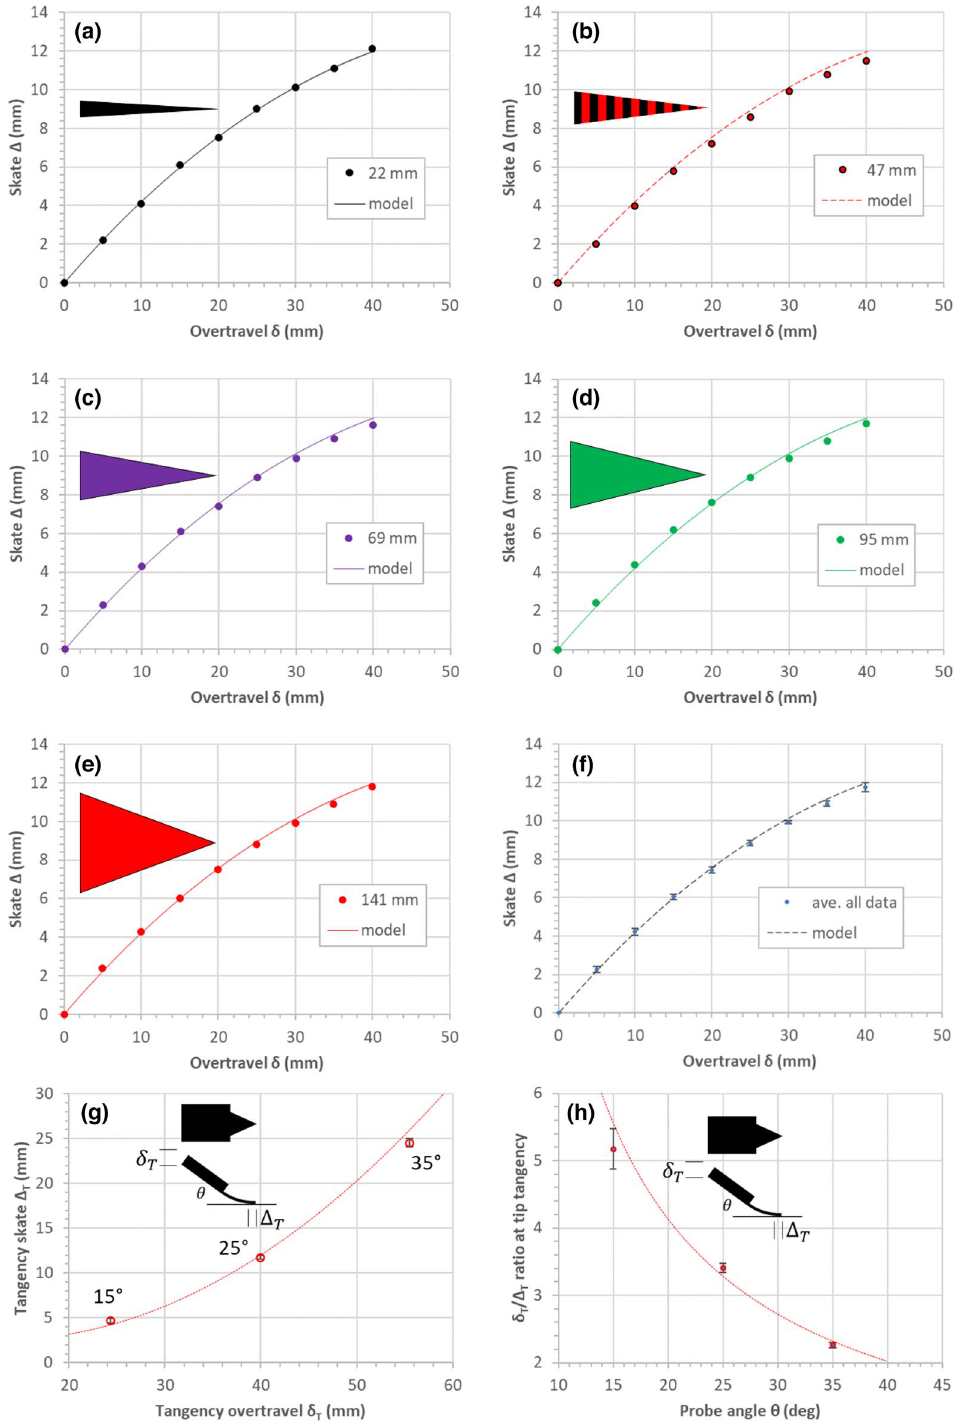
Figure 5. Experimental results of skate/overtravel of triangular cantilevers. ( a – e ) Skate versus overtravel for the five different triangulate cantilevers. ( f ) Averaged data plotted. ( g ) The tangency skate plotted as a function of tangency overtravel. ( h ) The tangency overtravel/tangency skate ratio plotted as a function of the cantilever tilt angle. The traces (solid and dashed) correspond to the mathematical model developed in “Methods”. The cantilever tilt (probe) angle is